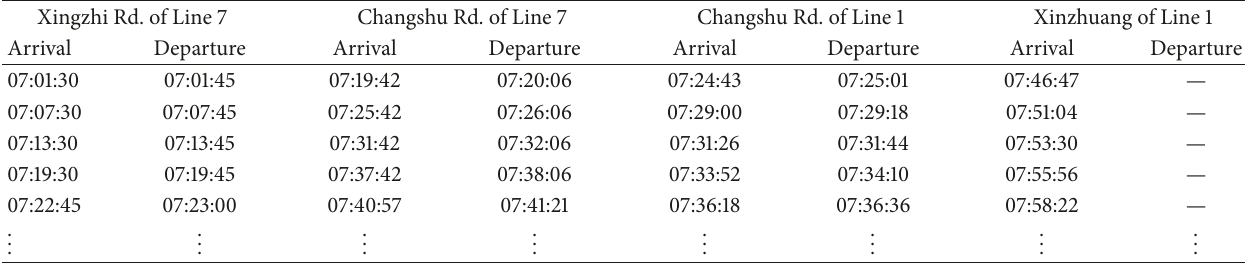
Table 4: The real timetable of trains on Route 1.